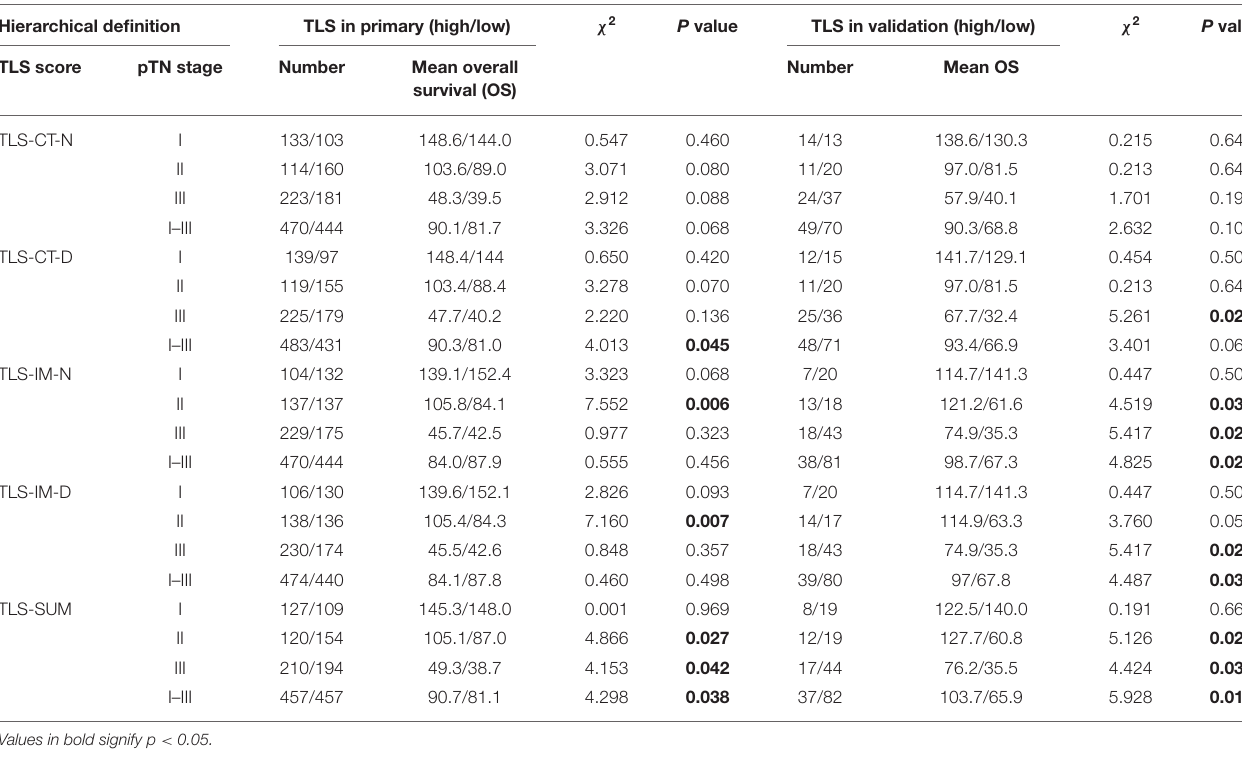
TABLE 1 | Hierarchical K–M survival analysis of tertiary lymphoid structure (TLS) and pathological tumor and lymph node (pTN).